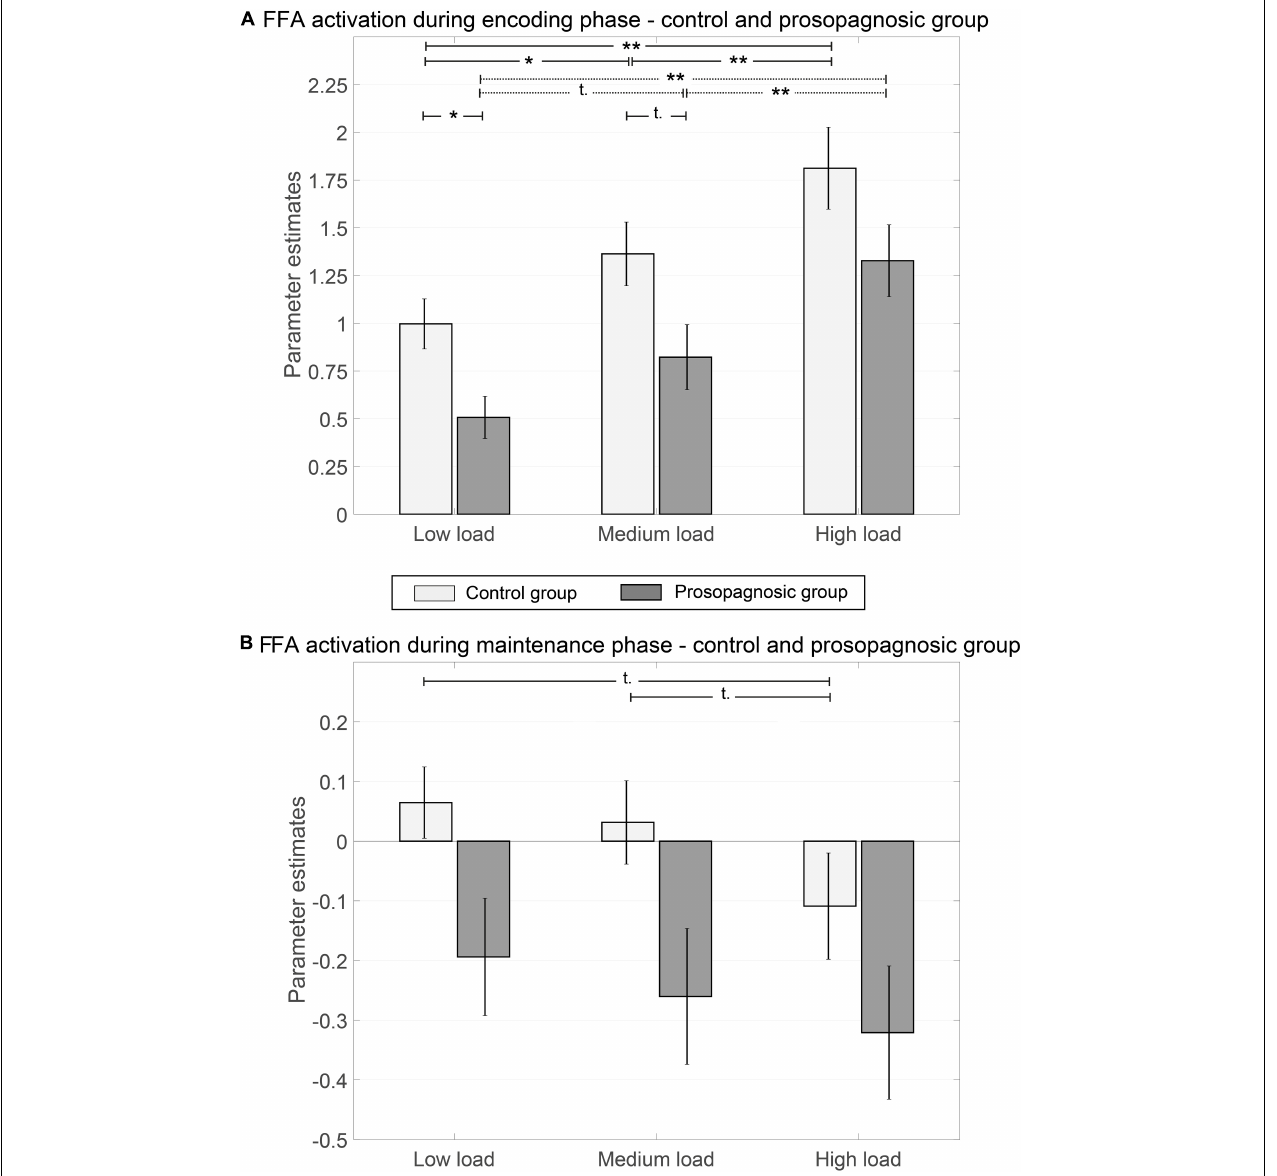
FIGURE 4 | Parameter estimates of right FFA for control and prosopagnosic subjects during encoding (A) and maintenance phase (B) of the different memory conditions including standard error of the mean; *( p < 0.5), **( p < 0.01), ***( p < 0.001), t, trend; if not otherwise stated not